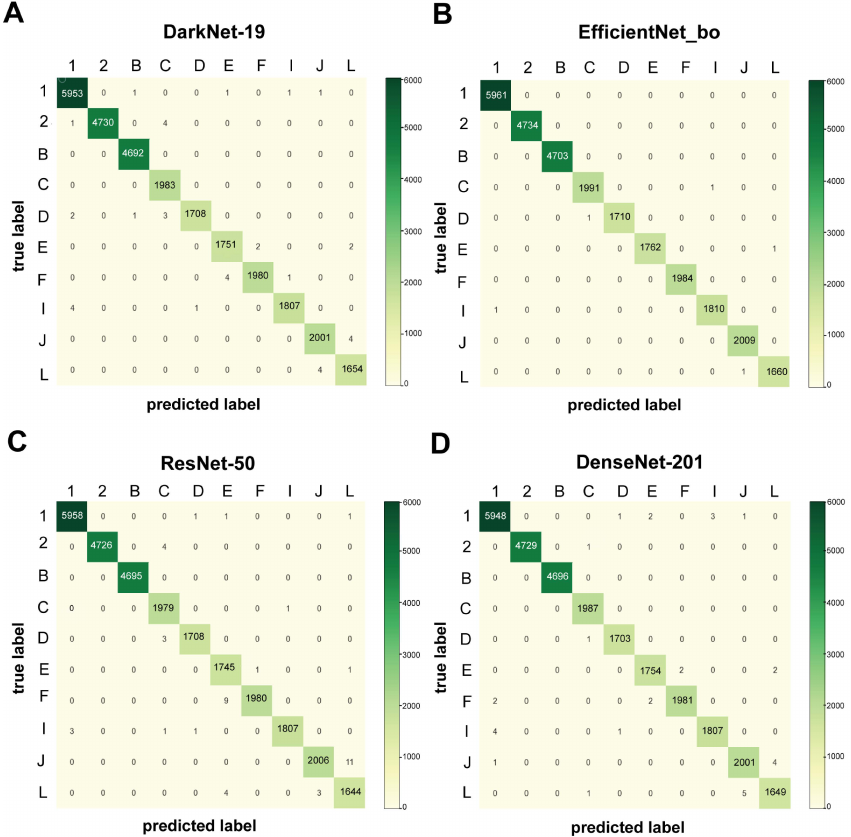
Figure 9. Confusion matrix of character classification of top 10 classes from 4 CNN networks: DarkNet-19 ( A ), EfficientNet-B0 ( B ), ResNet-50 ( C ), and DenseNet-201 ( D